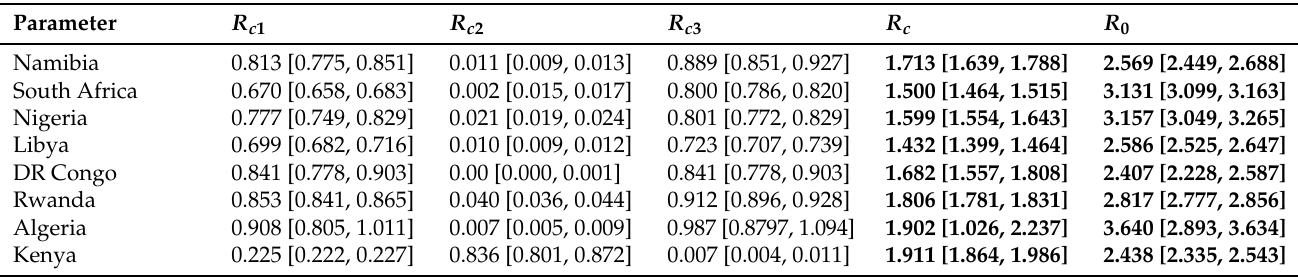
Table A7. Estimated values for the basic and control reproduction numbers and its components for each country with 95% confidence